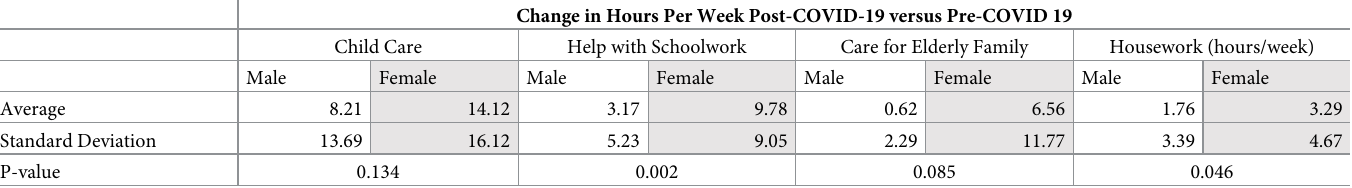
Table 5. Reported change in the number of hours per week spent caring for children, assisting with schoolwork, caring for elderly family members and housework pre- and post- COVID-19 for males and